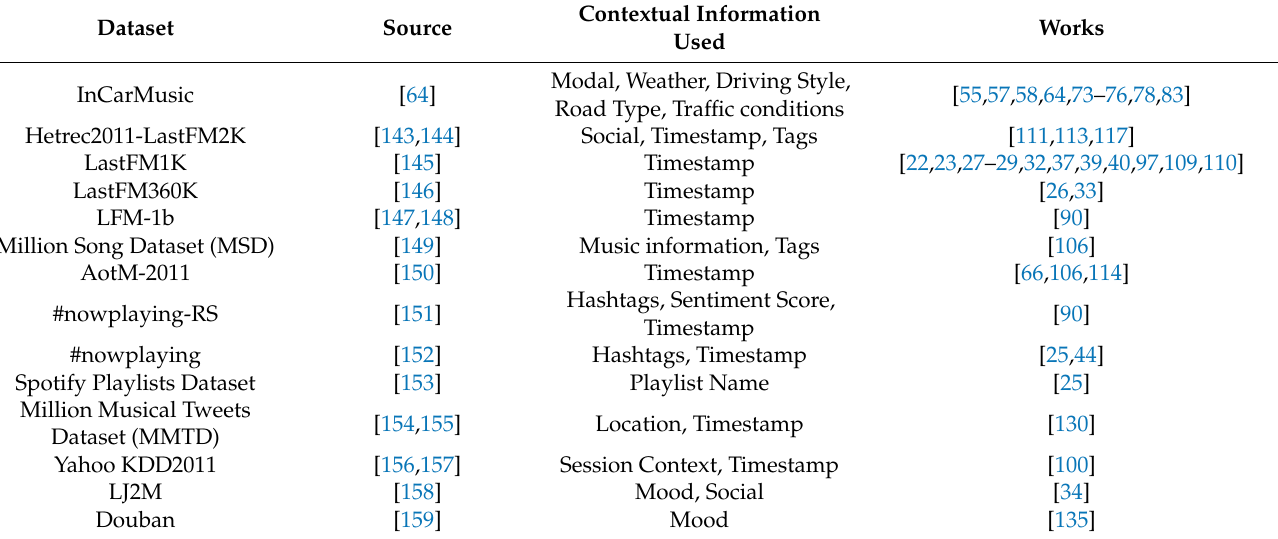
Table 6. Public datasets for context-aware recommender systems (CARS) in the music